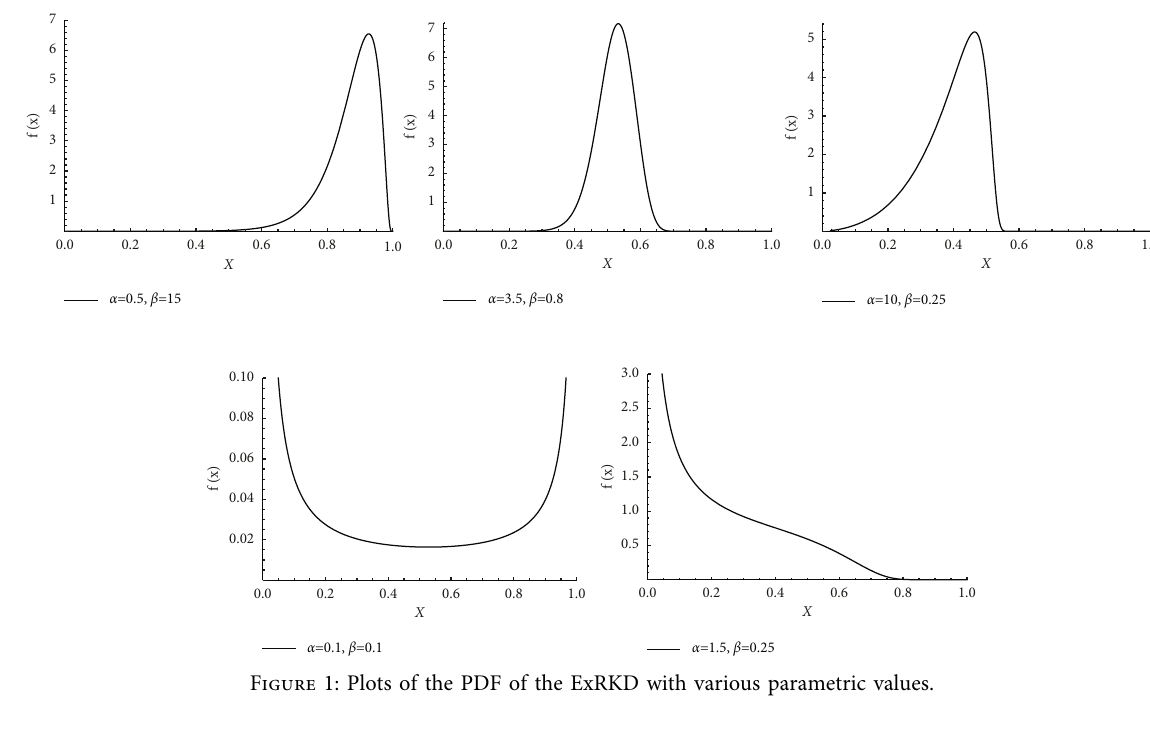
Figure 1: Plots of the PDF of the ExRKD with various parametric values.